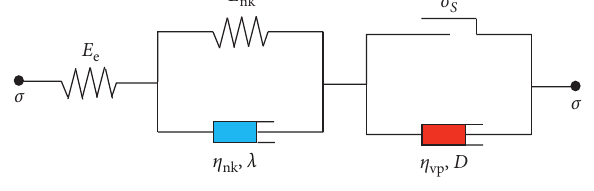
Figure 4: Nonlinear damage creep